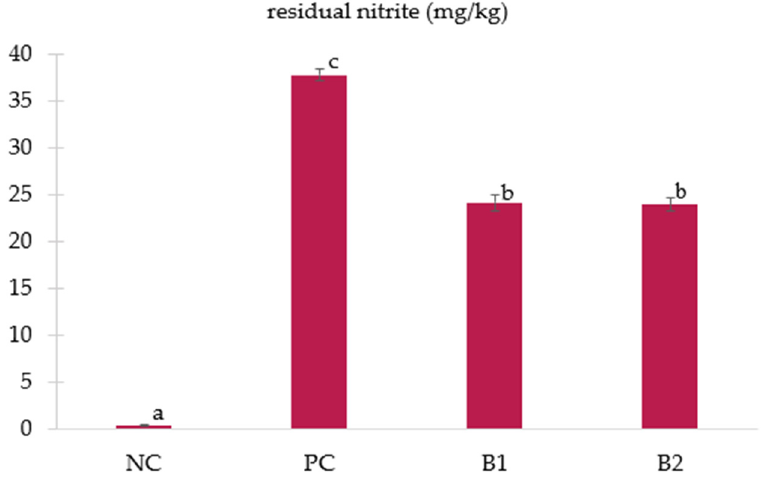
Figure 4. The effect of alternative nitrite sources on residual nitrite (mg/kg) of cured pork loin (mean ± SE); NC—negative control (pork loins soaked in nitrite-free brine); PC—positive control (pork loins soaked in brine containing sodium nitrite); B1—pork loins soaked in brine containing plasma-activated powder of cow milk; B2—pork loins soaked in brine containing plasma-activated powder of soy milk; B2—pork slices soaked with brine based on plasma-activated powder of soy milk; a–c—the mean values with different letters differ statistically significantly ( p < 0.05).